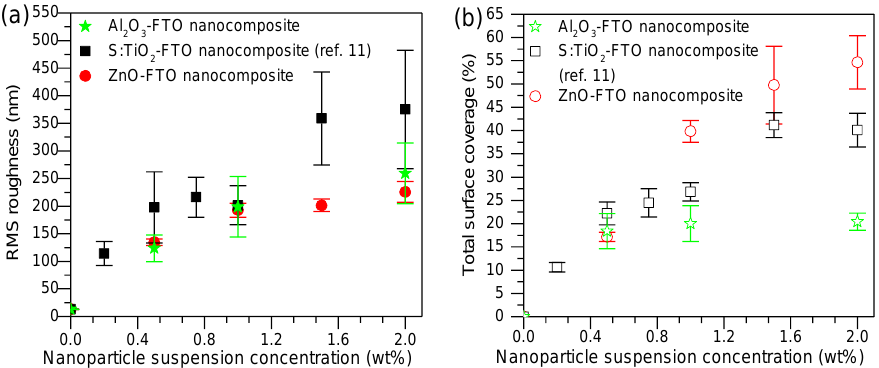
Figure 2. ( a ) Root-mean-square (RMS) roughness and ( b ) total surface coverage plotted against nanoparticle suspension concentration for Al 2 O 3 -FTO, S:TiO 2 -FTO (as reported in [11]), and ZnO-FTO nanocomposites. At least five different areas were measured on each sample to deduce the corresponding values and associated error bars.